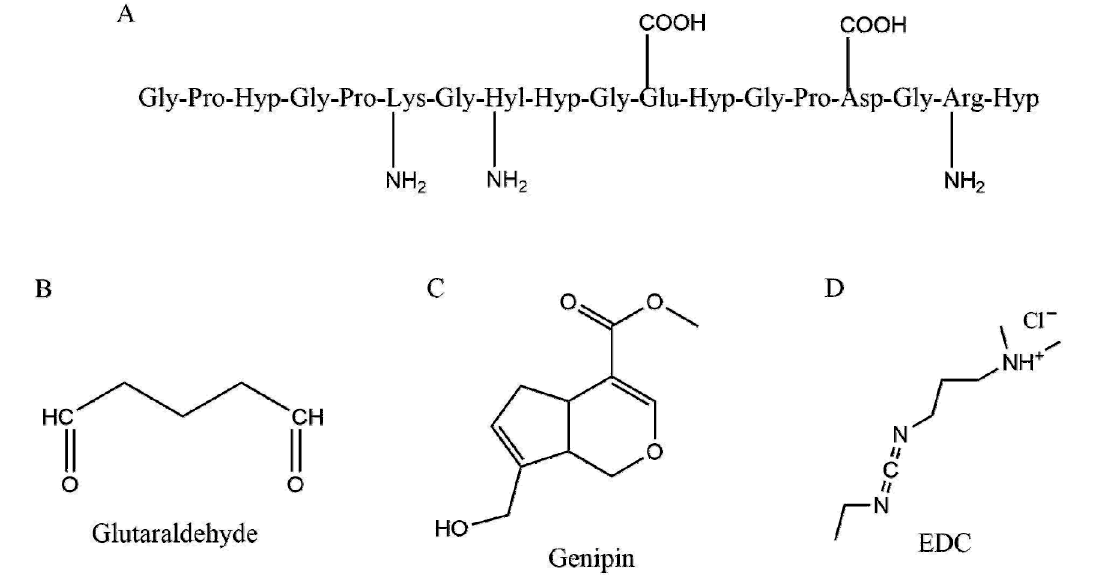
Figure 2. Chemical crosslinking of collagen. Crosslinks are primarily introduced in collagen by targeting carboxylic acid groups on Asp and Glu residues, or amines on Lys, Hyl, and Arg groups ( A – D ) show some common crosslinkers used to modify collagen.